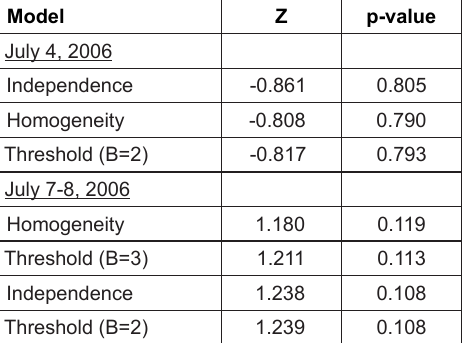
Table 12. Tests for randomness of collared caribou for the Bluenose-West July 4 and July 7-8, 2006 data